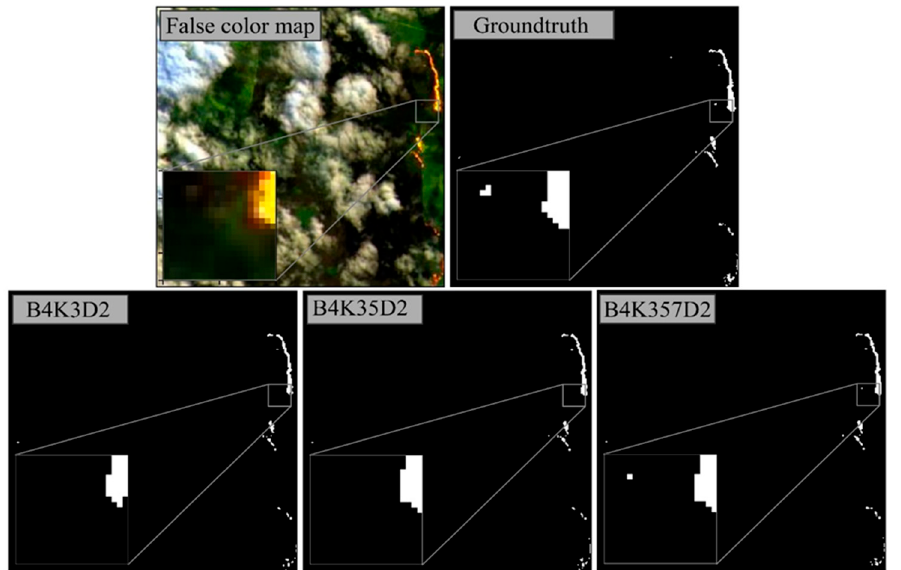
Figure 12. The effect of simultaneous use of several convolution kernels with different sizes for AFD in MultiScale-Net.